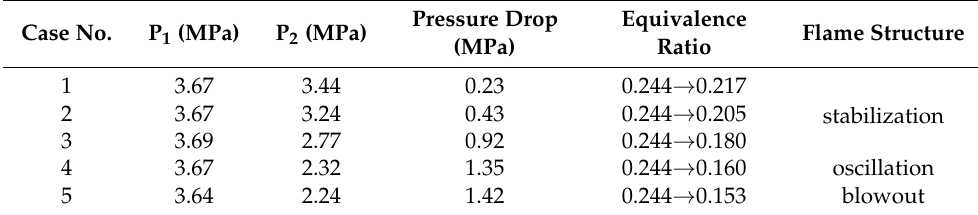
Table 1. Specific information of all experiment cases.